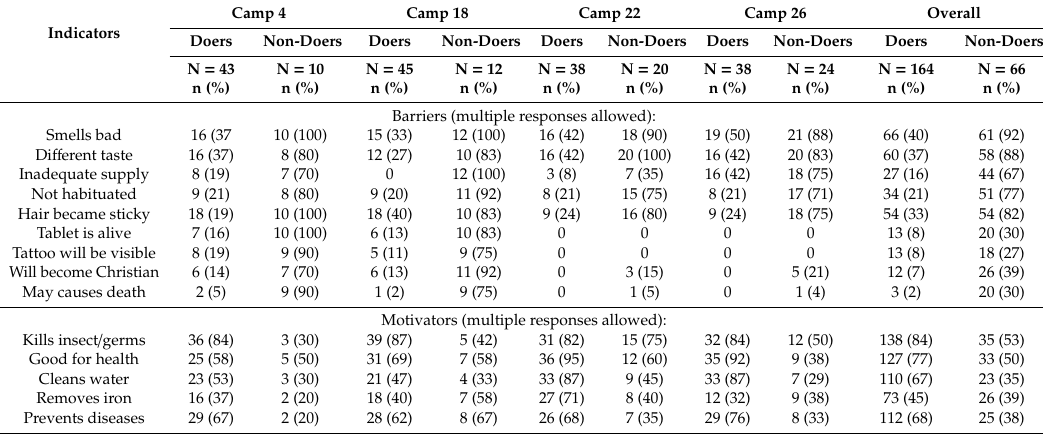
Table 3. Barriers and motivators for water treatment by